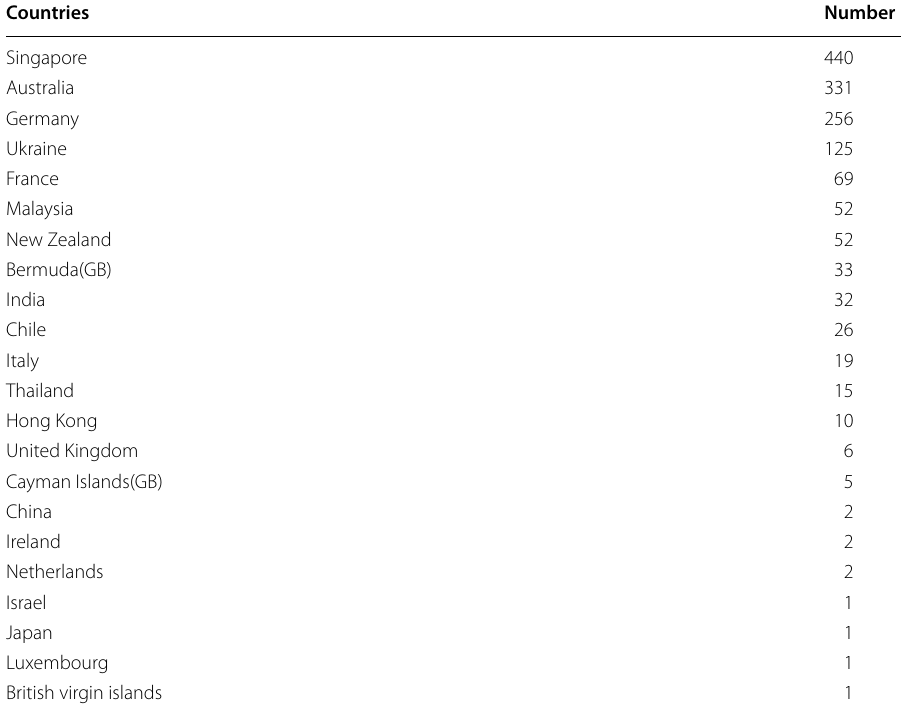
Table 3 20 most frequent countries in the 10 top-k cores (992 entities) Countries Number